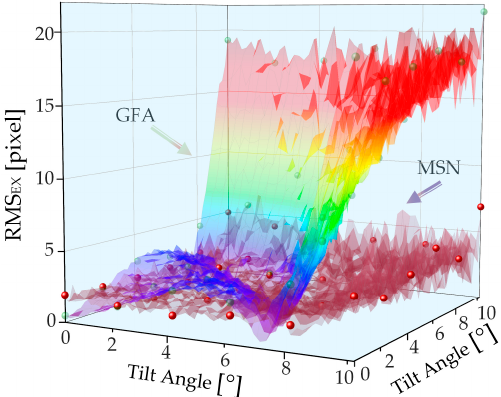
Figure 8. Simulation results of the root-mean-square values of the peak extraction errors of two CCDs when exposed to 2D tilt.